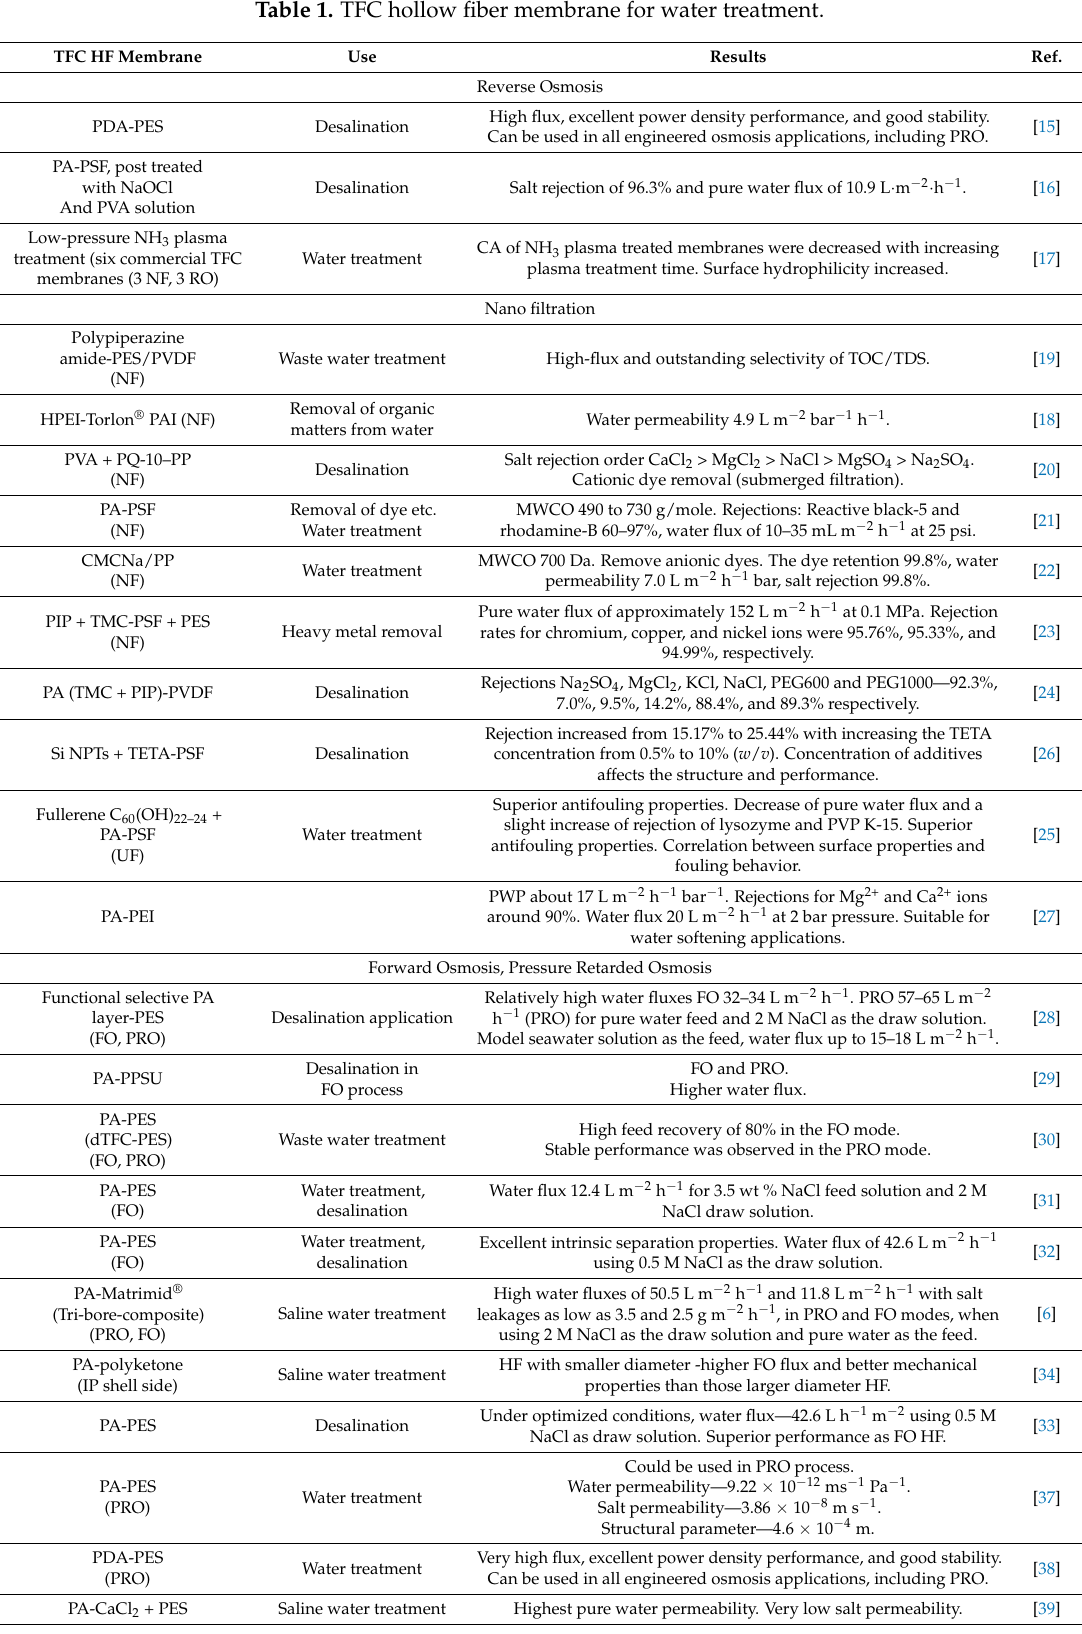
Table 1. TFC hollow fiber membrane for water